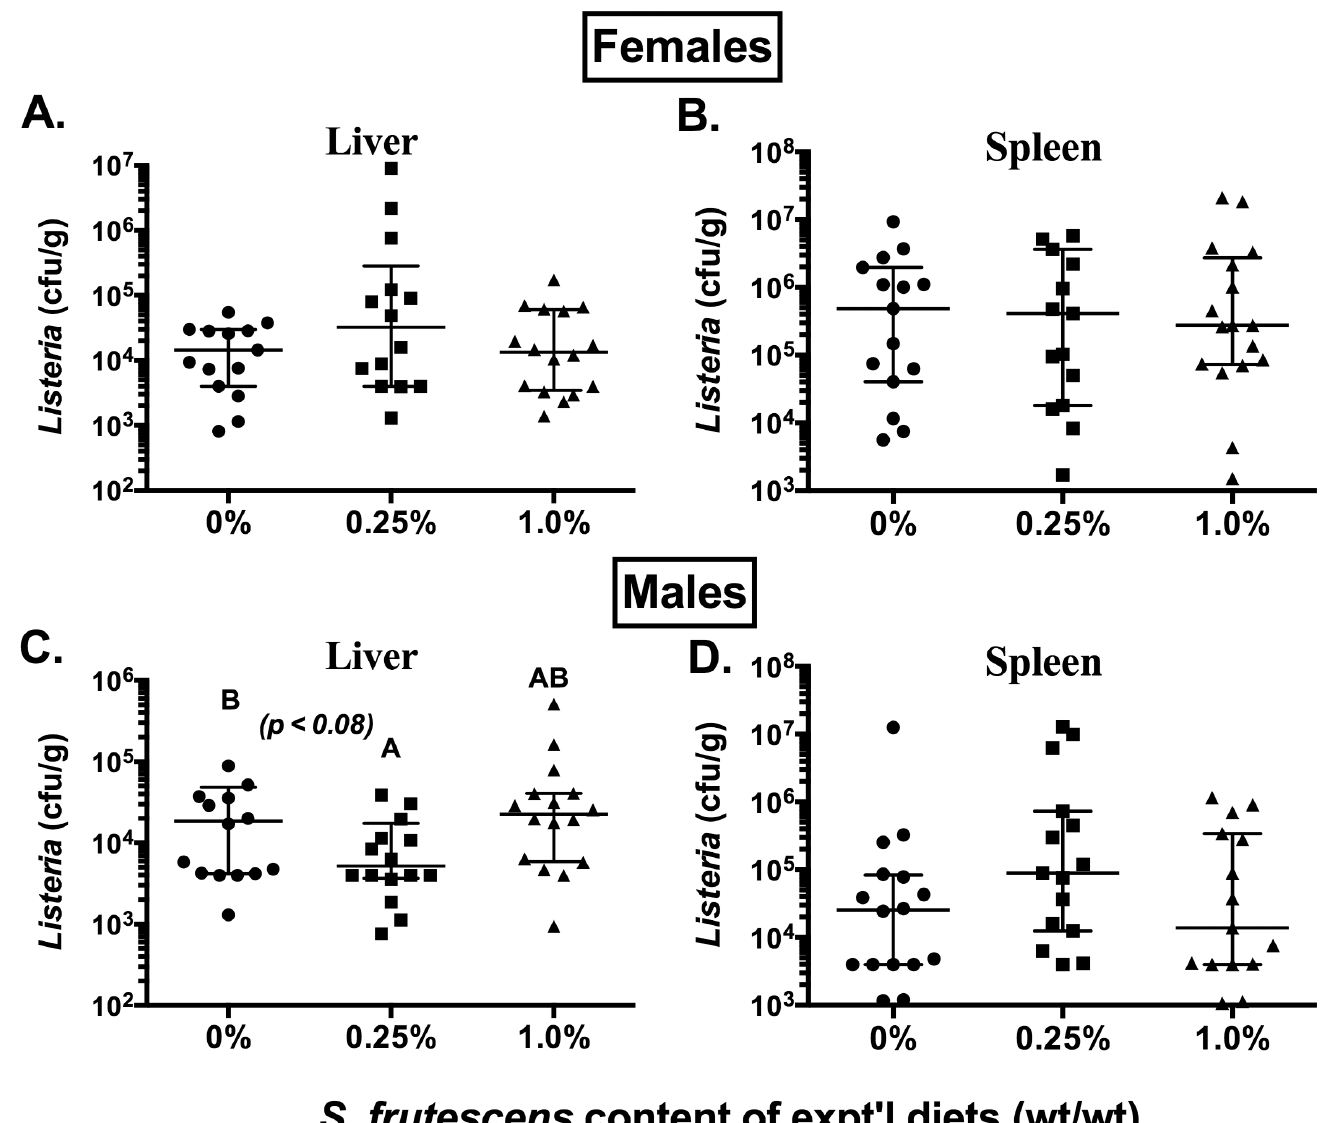
Fig 1. Impact of S . frutescens Consumption on Host Clearance of an Experimental Infection with L . monocytogenes . Female and male BALB/c ( L . monocytogenes ) mice were randomly assigned to one of three treatment groups: 0, 0.25, or 1.0% (wt/wt) S . frutescens in an AIN93G-type diet. After consuming diets for ~4 wks, all mice received an intravenous injection with ~10 4 cfu of L . monocytogenes (EGD strain) in 0.2 mL of sterile, endotoxin-free phosphate-buffered saline. Liver and spleen samples were harvested three days after challenge and colony-forming units ( cfu ) were determined by a fluorescence-based microplate assay of tissue homogenates. Each symbol represents the data from a single mouse with the median and intra-quartile range